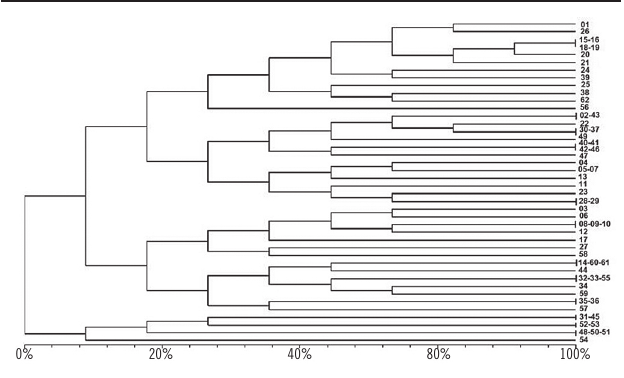
figurE 2 − Dendrogram of genetic similarity derived from Dice similarity coefficient showing the relationship between the evaluated A. baumannii